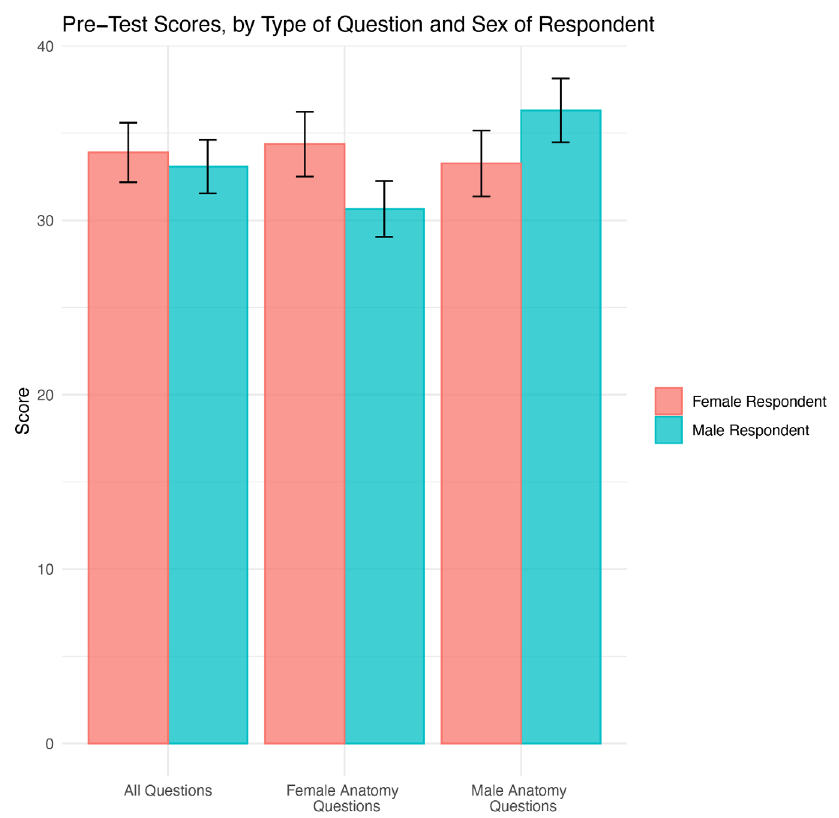
Figure 7. Pre-test scores by type of question and sex of respondent. Bars represent the standard error of the mean.